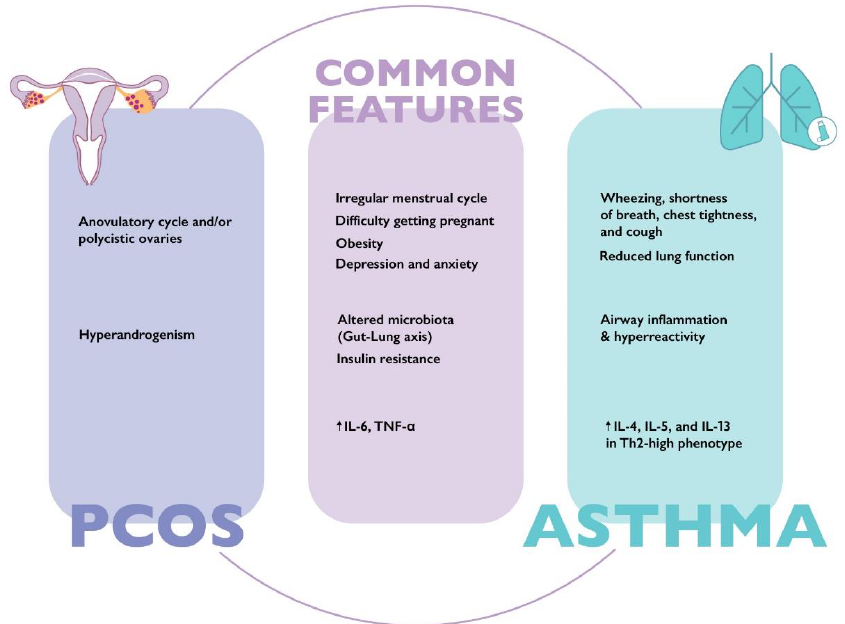
Figure 1. Main clinical and laboratory characteristics of asthma and polycystic ovary syndrome. IL-4: interleukin 4; IL-5: interleukin 5; IL-6: interleukin 6; IL-13: interleukin 13; TNF- α : tumor necrosis factor alpha; Th2: T helper 2.